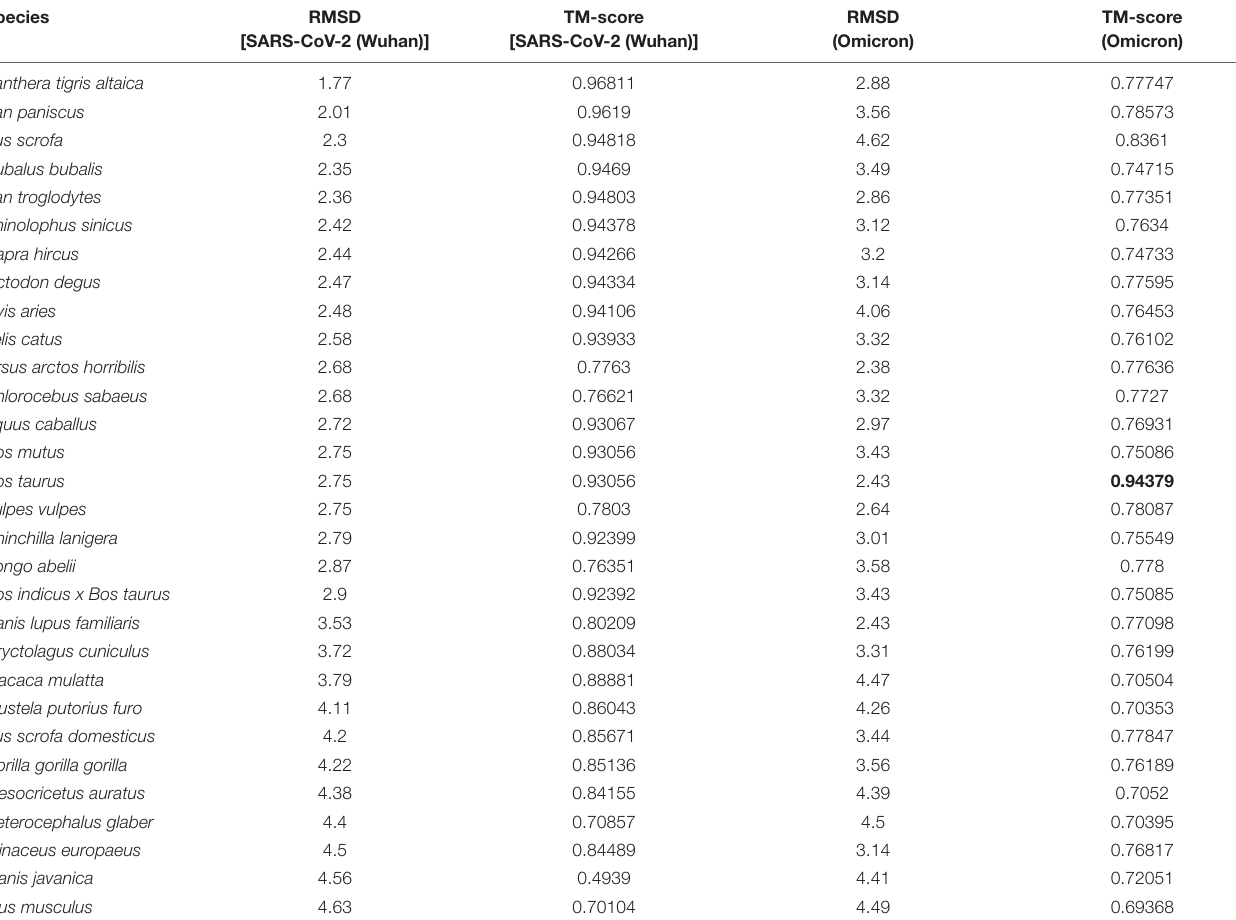
TABLE 3 | Structural similarity of M2 (ACE2)-RBD in Homo sapiens with other 30 species for SARS-CoV-2 (Wuhan) and Omicron. Species